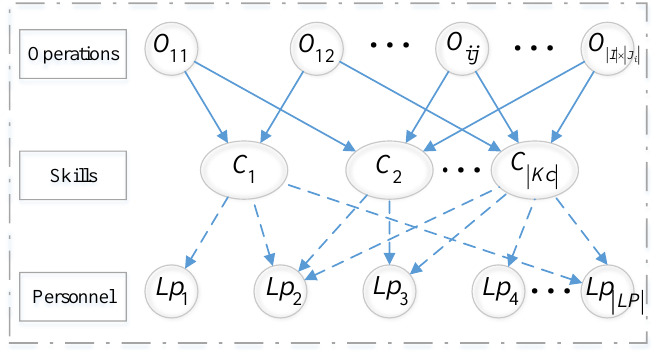
Figure 4. Matching relationship between maintenance operations, skills, and personnel.